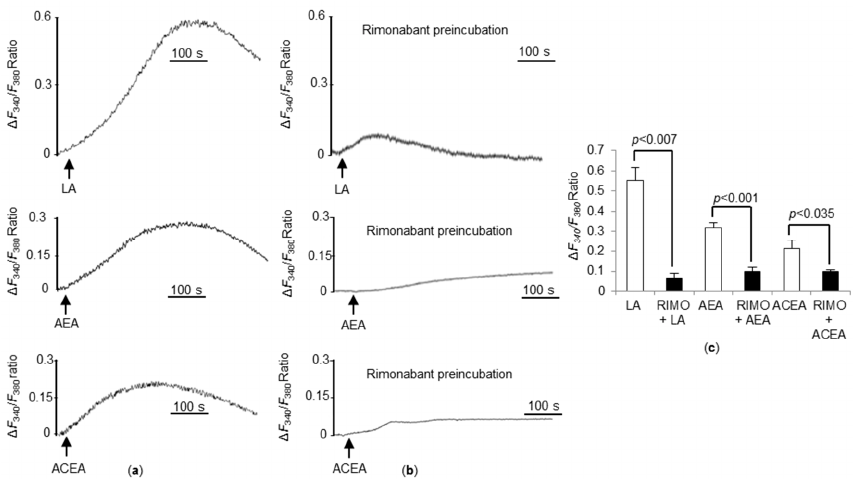
Figure 6. Effects of rimonabant on linoleic acid (LA) and cannabinoid ‐ induced Ca 2+ signaling in TBC. Ca 2+ imaging studies were performed in calcium ‐ containing buffer. The changes in free intracellular Ca 2+ concentrations ( Δ F 340 / F 380 ) were monitored under the Nikon microscope (TiU) by using S ‐ fluor 40× oil immersion objectives. Graphs show the increase in [Ca 2+ ] i in taste bud cells freshly isolated from WT mice following addition of LA (25 μ M), anandamide (AEA, 5 μ M), and ACEA (1.5 μ M) ( a ). WT TBC before the addition of LA (25 μ M), AEA (5 μ M) and ACEA (1.5 μ M) were preincubated (15 min) with rimonabant (50 μ M) ( b ). The arrowheads indicate when the test molecules were added. Changes in Δ F 340 / F 380 Ratio induced by LA (25 μ M), AEA (5 μ M), and ACEA (1.5 μ M) in WT mice TBC after a preincubation with or without rimonabant (RIMO, 50 μ M) ( c ). Values are expressed as mean ± SEM ( n = 5).